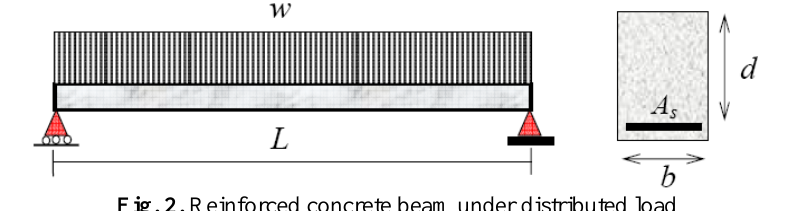
Fig. 2. Reinforced concrete beam under distributed load Table 1 . Statistical characteristics of basic random variables for dynamic system in Figure 1